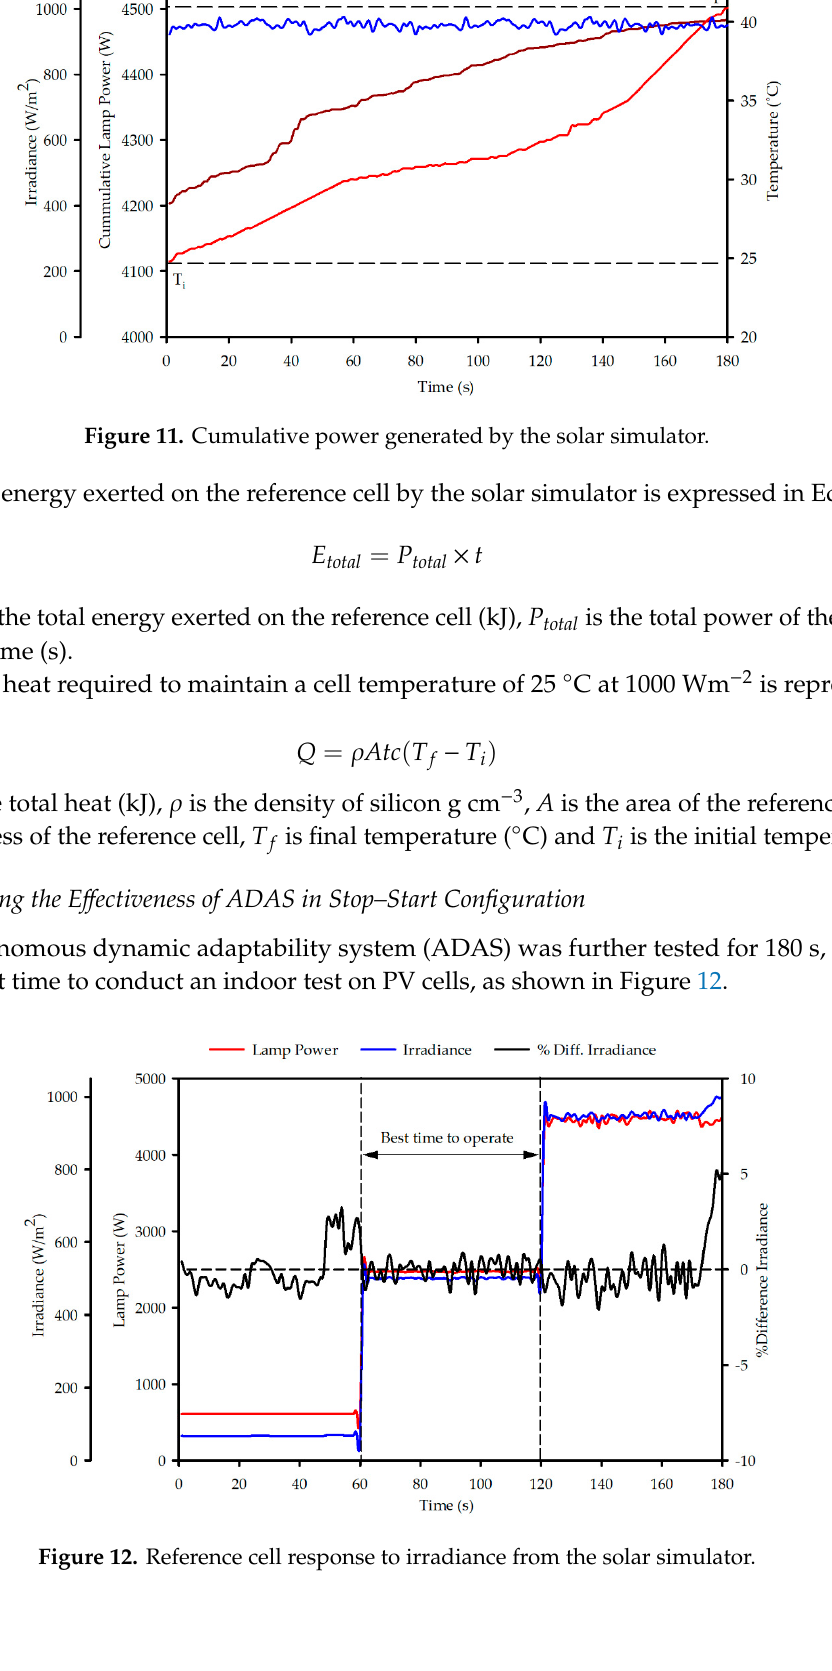
Table 1. Xenon arc lamp solar simulator performance classifications. Characteristics